Question: Briefly state, in one sentence, what is plotted here.
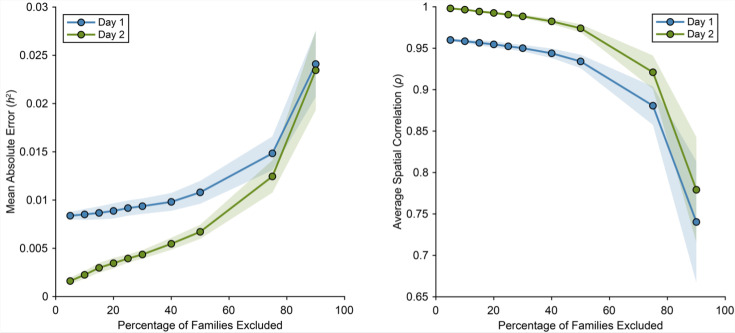
Answer: Blood oxygen level-dependent (BOLD) time course heritability magnitudes and spatial patterns are consistent in smaller subsamples. Scatter plots show that average BOLD time course heritability magnitudes (left) and spatial patterns in smaller subsamples of our data are consistent with those observed in the full sample (shading = standard deviation across 100 random subsamples at each percentage).